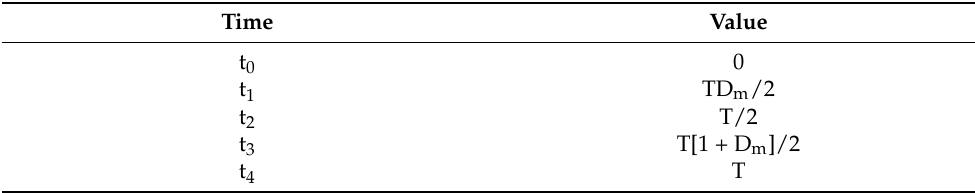
Figure 3. SPS operation ( a ) simulated circuit and ( b ) corresponding waveforms. Table 2. Switching cycle for one period for the SPS.